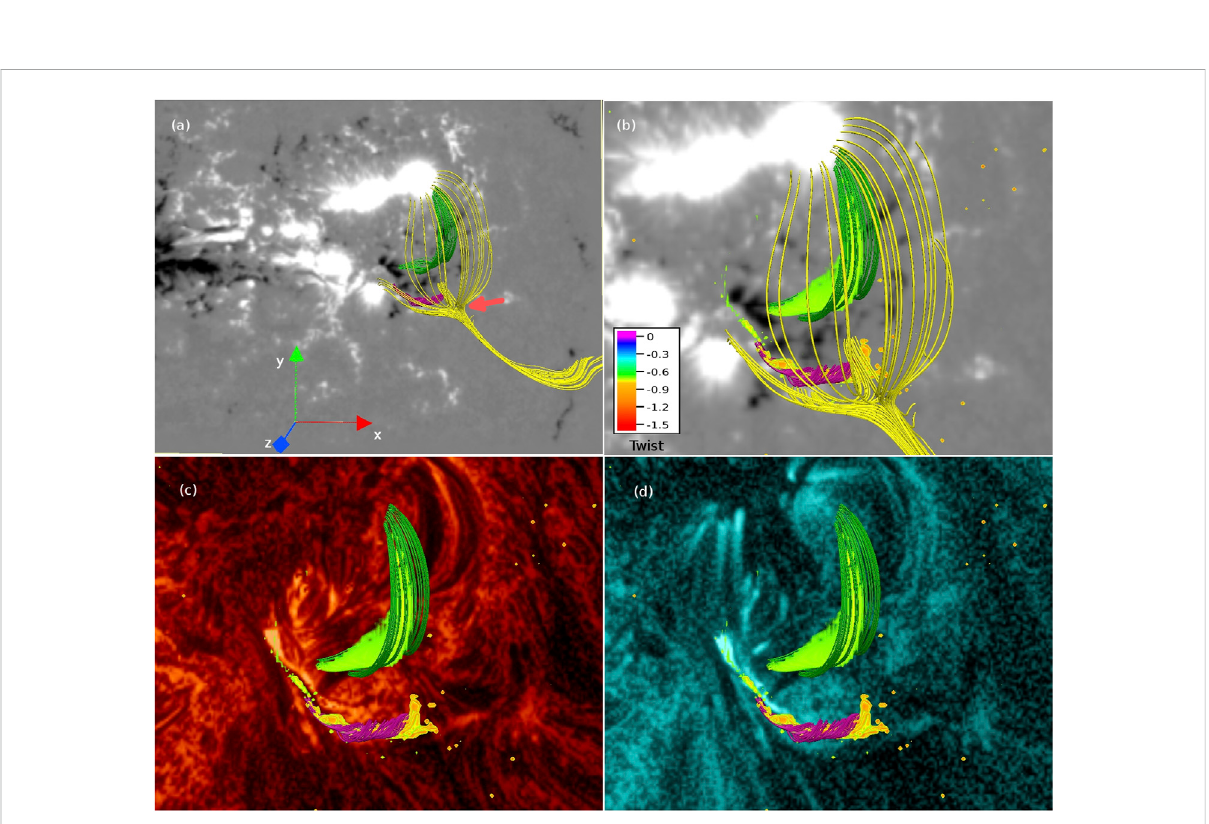
FIGURE 5 Panels (A) and (B) depict the zoomed-in view of the extrapolated MFLs with the magnetogram as the bottom boundary. The location of the 3D null is marked by a red arrow in panel (A) . The yellow MFLs represent the dome-shaped fan surface and spine axis of the 3D null. Panel (B) is further overlaid with the twist parameter — showing the existence of two twisted magnetic structures below the dome. Panel (C) plots the structures with 304 Åimageofaround10:34UTatthebottomboundary.The fi lament isalmost co-located withoneofthetwistedstructures plottedingreen. Panel (D) is overplotted with 131 Å image of around 10:34 UT at the bottom boundary — indicating the similar location of the magenta-colored twisted structure and the observed brightenings in 131